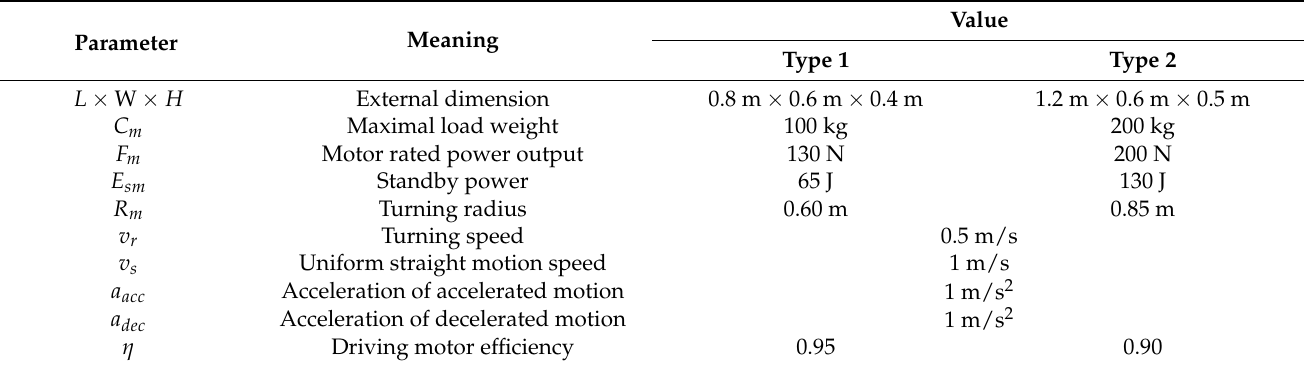
Table 8. The main technical parameters of the heterogeneous fleet AGVs.